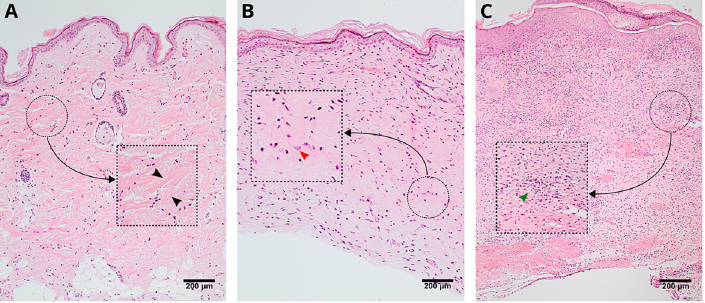
Figure 4. Wound histological representative images stained by hematoxylin-eosin showing a collagen fi ber (black arrow) ( A ), fi broblast (red arrow) ( B ), and in fl ammatory in fi ltrate (green arrow) ( C ). Scale bar 200 m m.